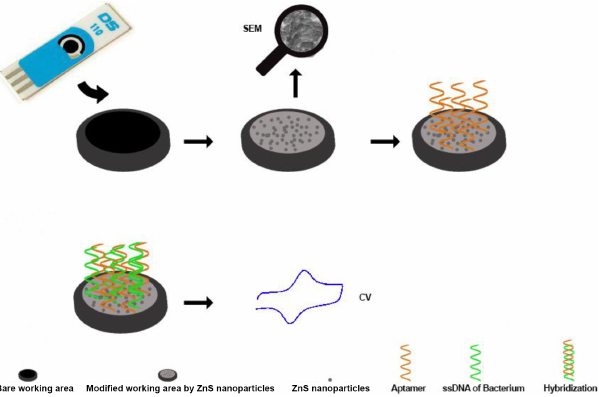
Figure 1. Schematic procedure to design and detect Aeromonas hy- drophila ; all actions were performed on a working area in a screen- printed electrode; the steps to design it were preparation of a bare electrode, modification with ZnS nanospheres, aptamer immobiliza- tion, hybridization for aptamers and Aeromonas hydrophila DNA and a product electrochemical redox signal respectively.